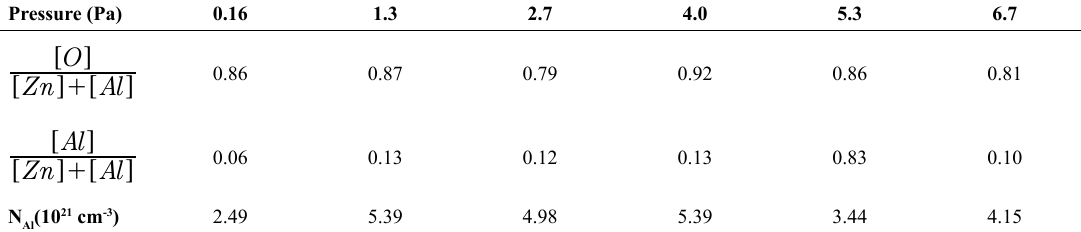
Table 2. The Oxygen and Al ratios deduced from the elemental composition obtained by EDS measurements. [Al]/([Zn]+[Al]) ratio in the metallic target is 0.05. N represents the density of Al atoms in the films. Al